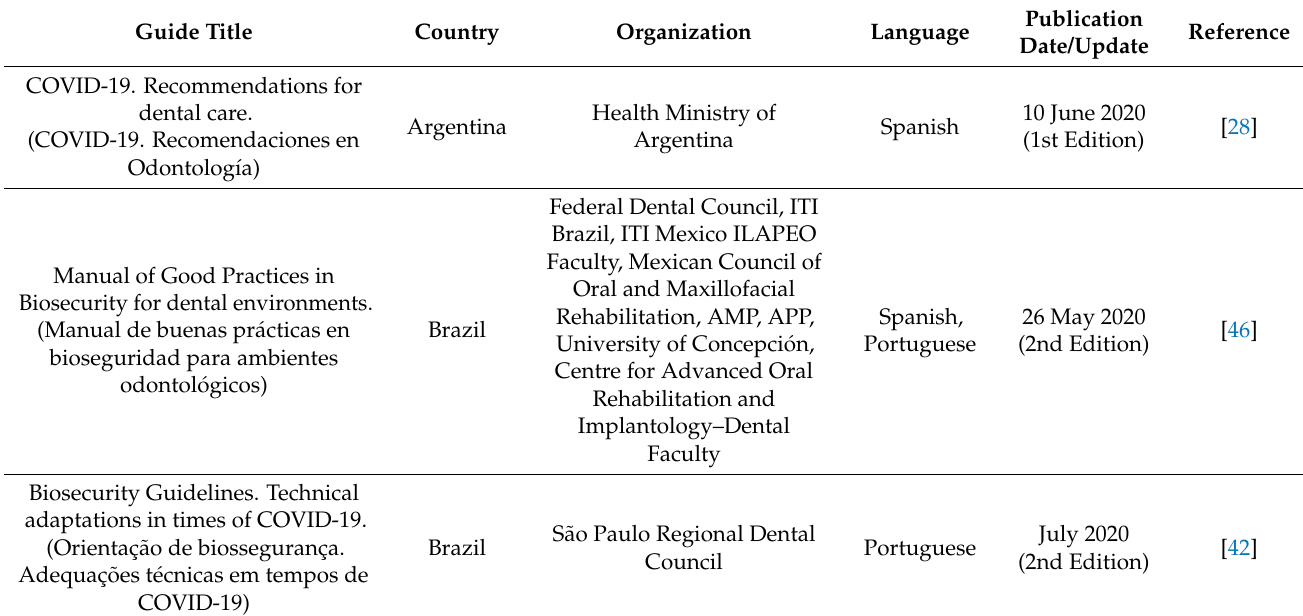
Figure 1. Flowchart of the CPGs included. Table 1. General information of the clinical practice